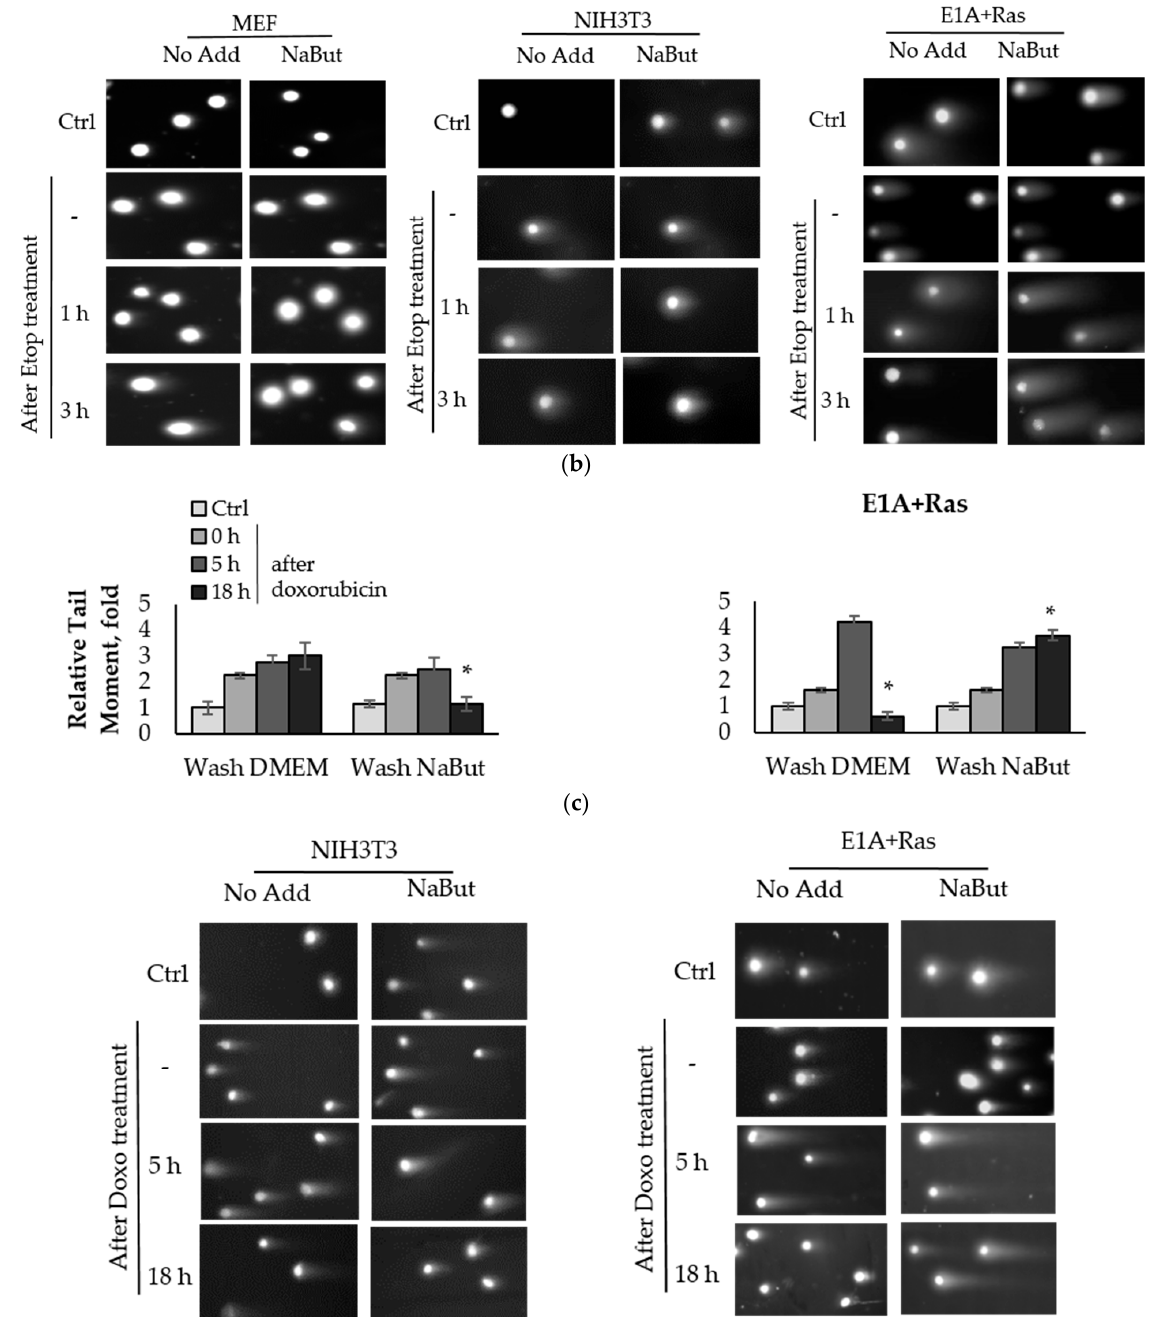
Figure 1. Sodium butyrate prolongs genotoxin-induced DNA double-strand breaks (DSBs) in oncogene-transformed cells but not in normal ones. Neutral comet assay data of non-transformed and transformed cells. Cells were untreated (Ctrl) or treated with 2.5 µM etoposide for 1 h ( a ) or 0.2 µg/mL doxorubicin for 40 min ( c ), then washed with or without sodium butyrate (NaBut) for 1–18 h. Comet assay data correspond to the relative number of DSBs and are represented as a mean of Olive tail moments, scaled to the untreated control (folds). Error bars indicate ± standard error of the mean. The statistical significance was determined using a Student’s t test (* = p < 0.05) between the Relative tail moment of the transformed vs. non-transformed doxorubicin/etoposide-treated cells washed with or without NaBut. ( b , d ) Representative images of experiments with etoposide ( b ) and doxorubicin ( d ). The images were obtained using an Axioskop, 10× lens.